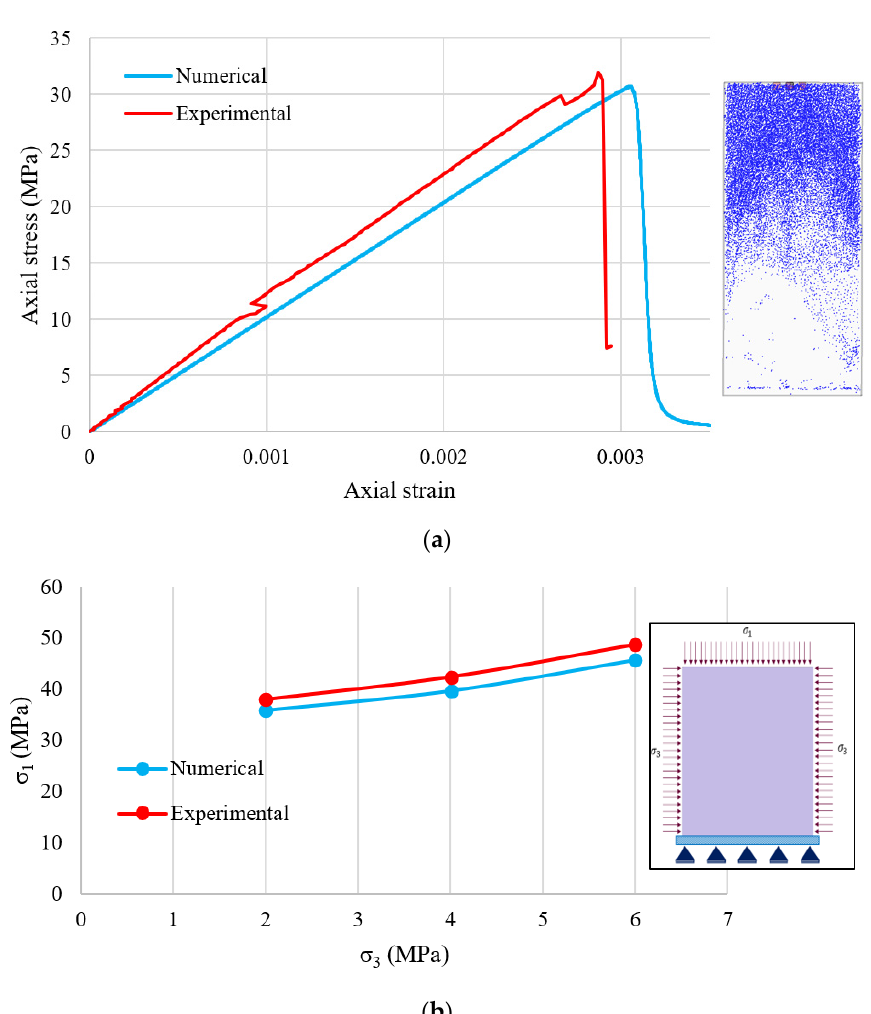
Figure 7. ( a ) stress-strain plot of unconfined compression tests, and ( b ) σ 1 – σ 3 plot of conventional triaxial tests.